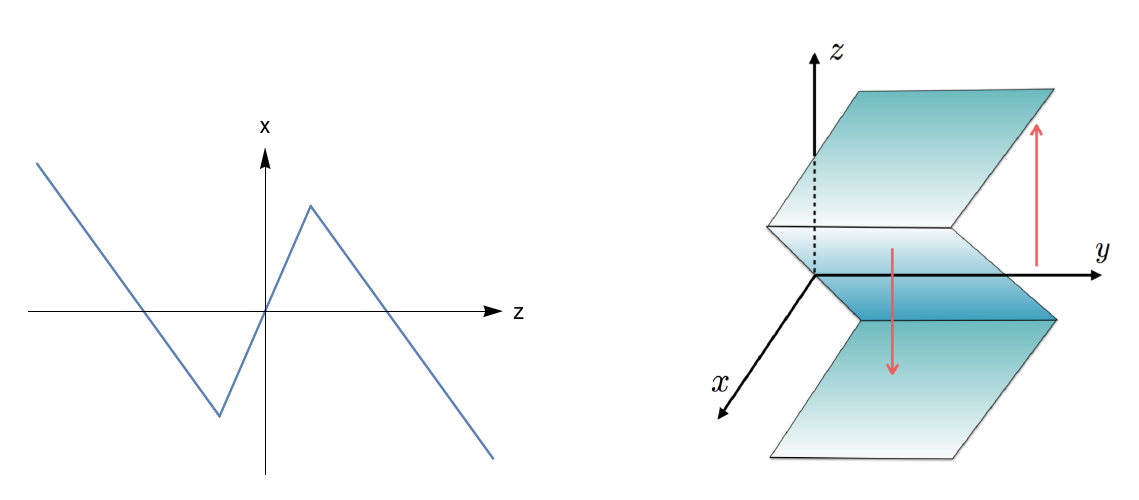
Fig. 8 Typical graph for ϕ ( Z ) and surface X = ϕ ( Z )